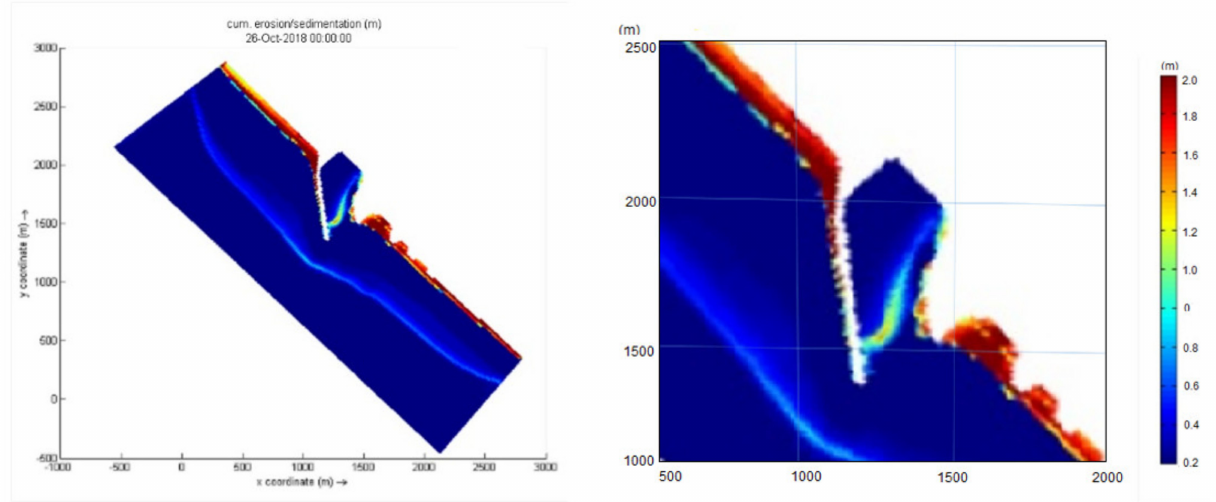
Figure 12. Erosion and sedimentation model after 1 month of